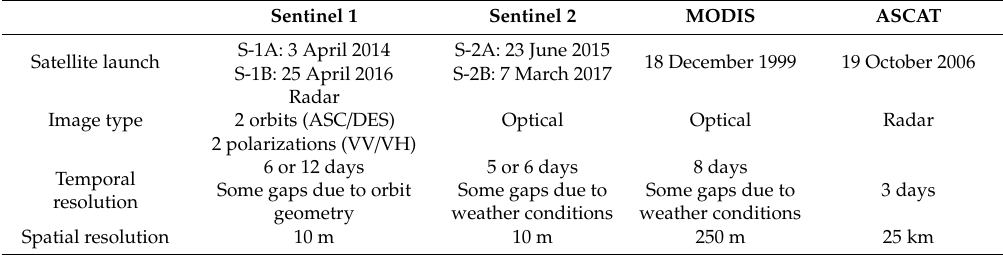
Table 1. Summary of satellite data